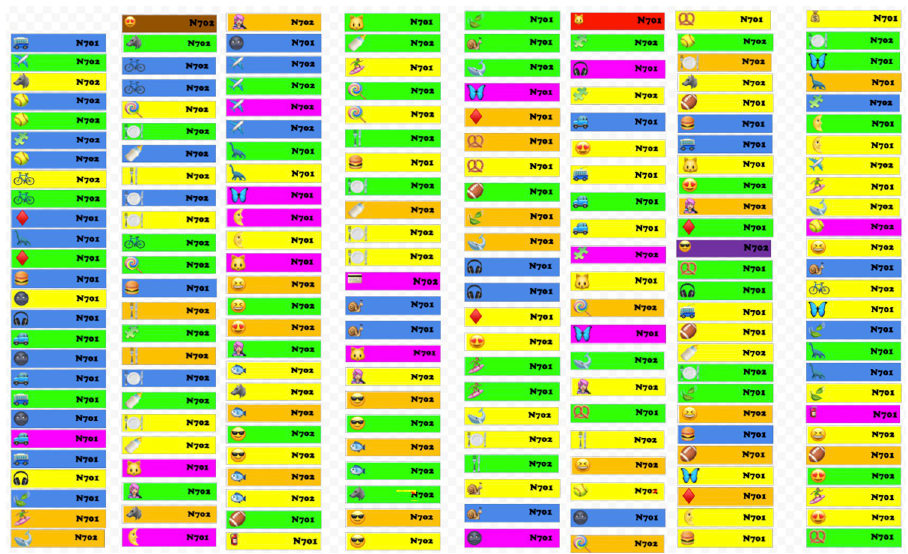
Fig 4. Starting screen of “Reads” in conceptual group learning